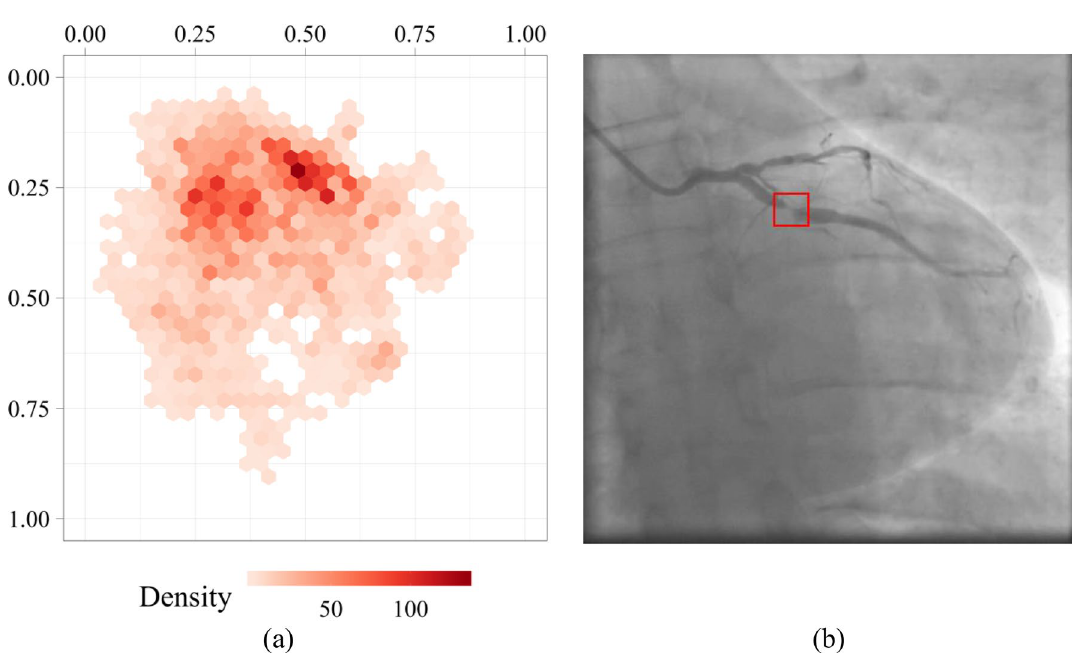
Figure 4. Distribution mapping of the stenosis density over the dataset ( a ) and an example of an angiography image with the labeled stenotic area ( b